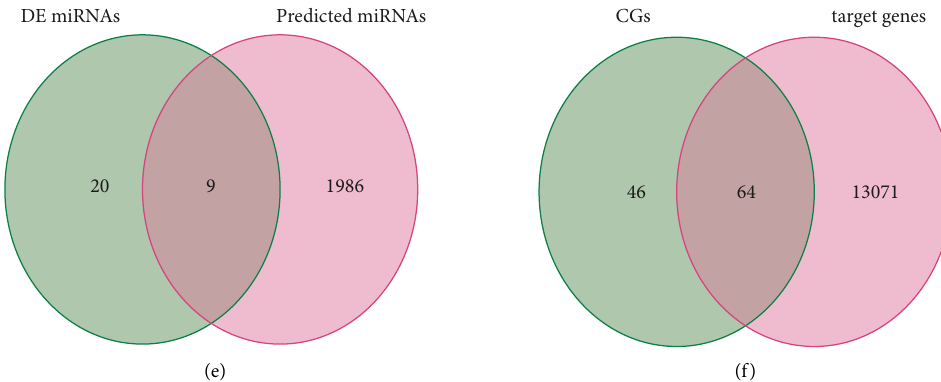
Figure 5: Identification of DE circRNAs, DE miRNAs in atrial fibrillation. Volcano plots (a) and heat map (b) of DE circRNAs between atrial fibrillation and sinus rhythm group. Volcano plots (c) and heat map (d) of DE miRNAs between atrial fibrillation and sinus rhythm group. (e) A total of 9 overlapping miRNAs between the DE miRNAs and the predicted miRNAs were identified. (f) A total of 64 overlapping mRNAs between the common genes (CGs) and the targeted genes were